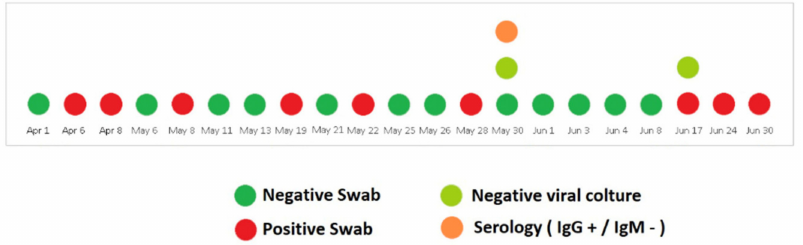
Figure 2. Timeline of SARS-CoV-2 nucleic acid testing results from nasopharyngeal swabs along with the anti-SARS-CoV-2 serology and viral culture